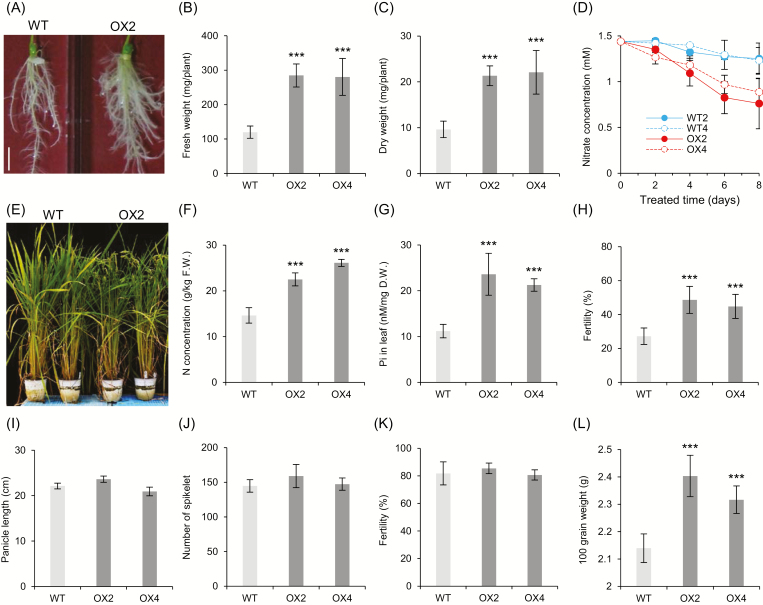
Characterization of OsZHD2-overexpressing plants. (A–D) Agronomic traits of OsZHD2-overexpressing plants at seedling stages. (A) Root phenotypes at 14 DAG for plants grown on MS medium. Scale bar=1 cm. (B) Fresh weights of roots at 12 DAG. (C) Dry weights of roots at 12 DAG. (D) Efficiency of nitrate uptake. Blue lines, WT; red lines, overexpressing plants. (E) Phenotype of WT and OsZHD2 OX plants grown under low-nutrient conditions in the controlled growth room. (F) Nitrogen concentrations in the flag leaves. (G) Pi concentration in the flag leaves. (H) Seed fertility. n=6. (I–L) Agronomic traits of OsZHD2 OX plants under paddy field conditions. (I) Panicle length. (J) Total spikelet number. (K) Seed fertility. (L) 100-grain weight. n=5. Statistical significance is indicated by *** (P<0.001).